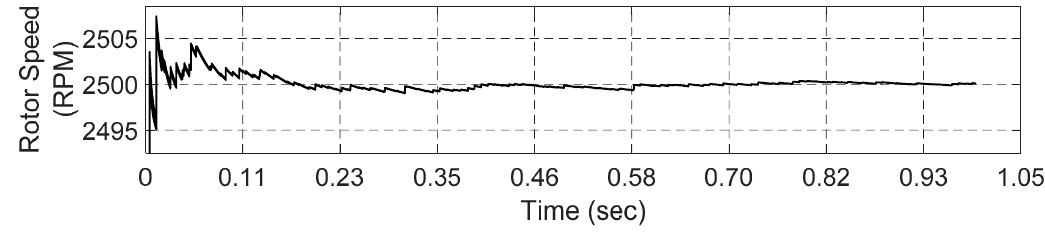
Figure 6. Constant speed environment, w r = 2500 rpm.